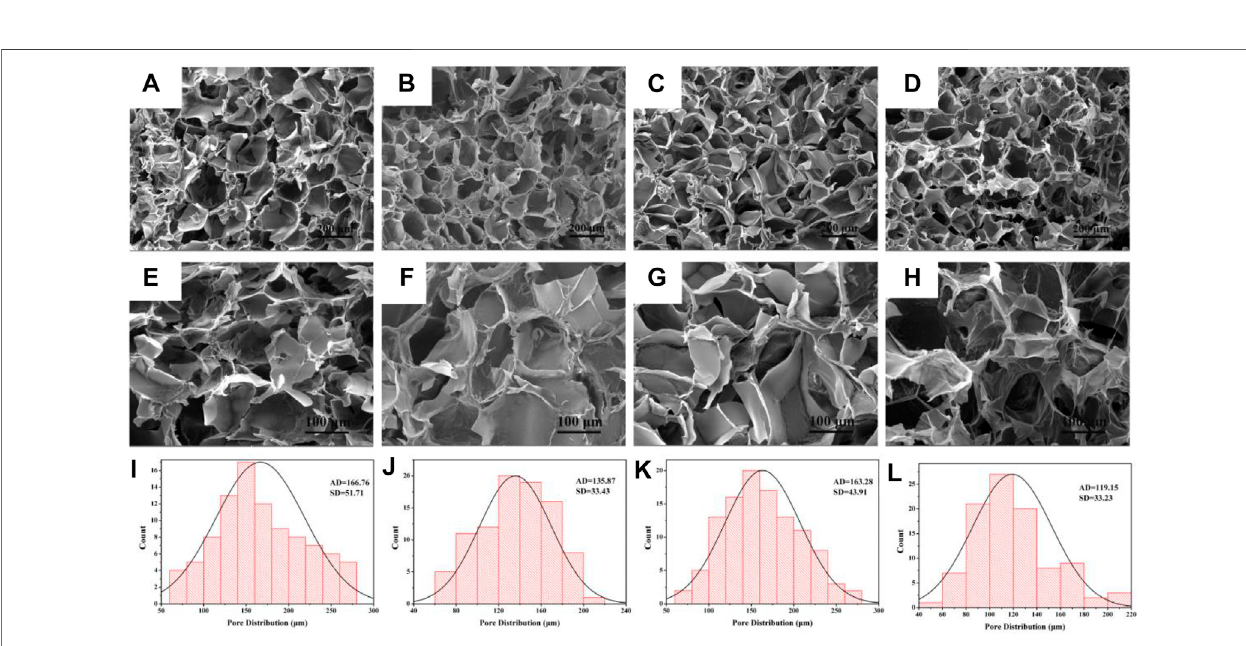
Frontiers in Bioengineering and Biotechnology |